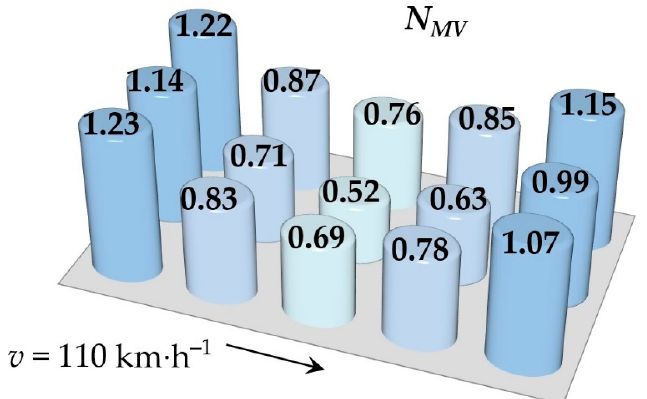
Figure 10. The distribution of the index N MV for a speed of 110 km ∙ h − 1 : the “Original” parameters.